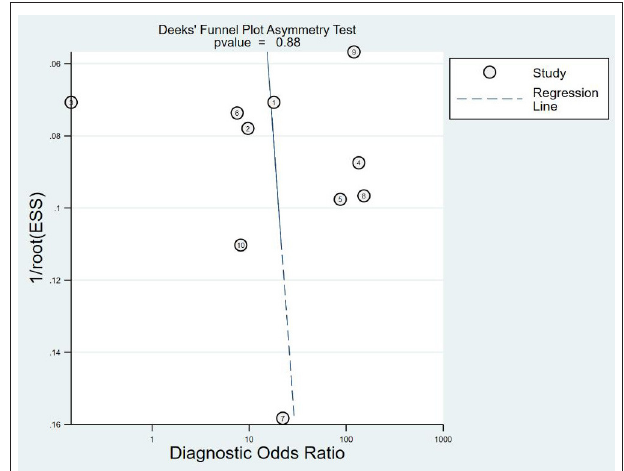
FIGURE 9 | Deek funnel test. ESS, explained sum of squares. Sum of squared deviations that reflect the degree of correlation between the independent and dependent variables.